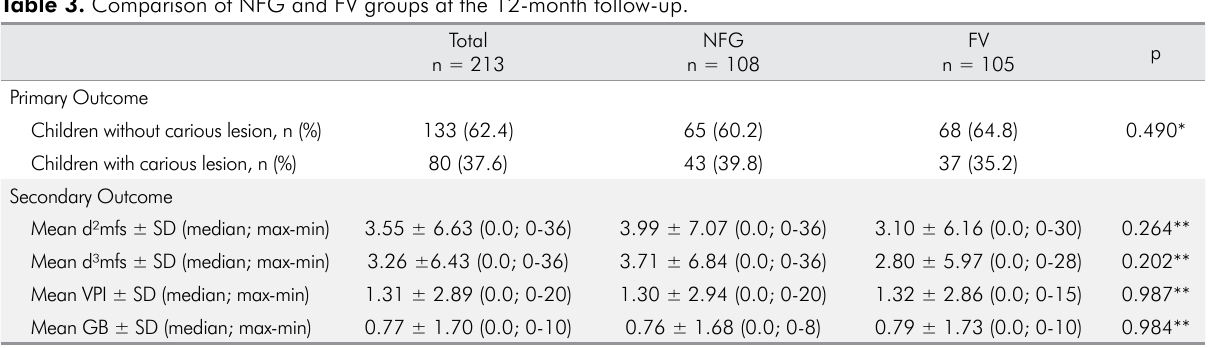
*Pearson’s Chi-square test; **Mann-Whitney